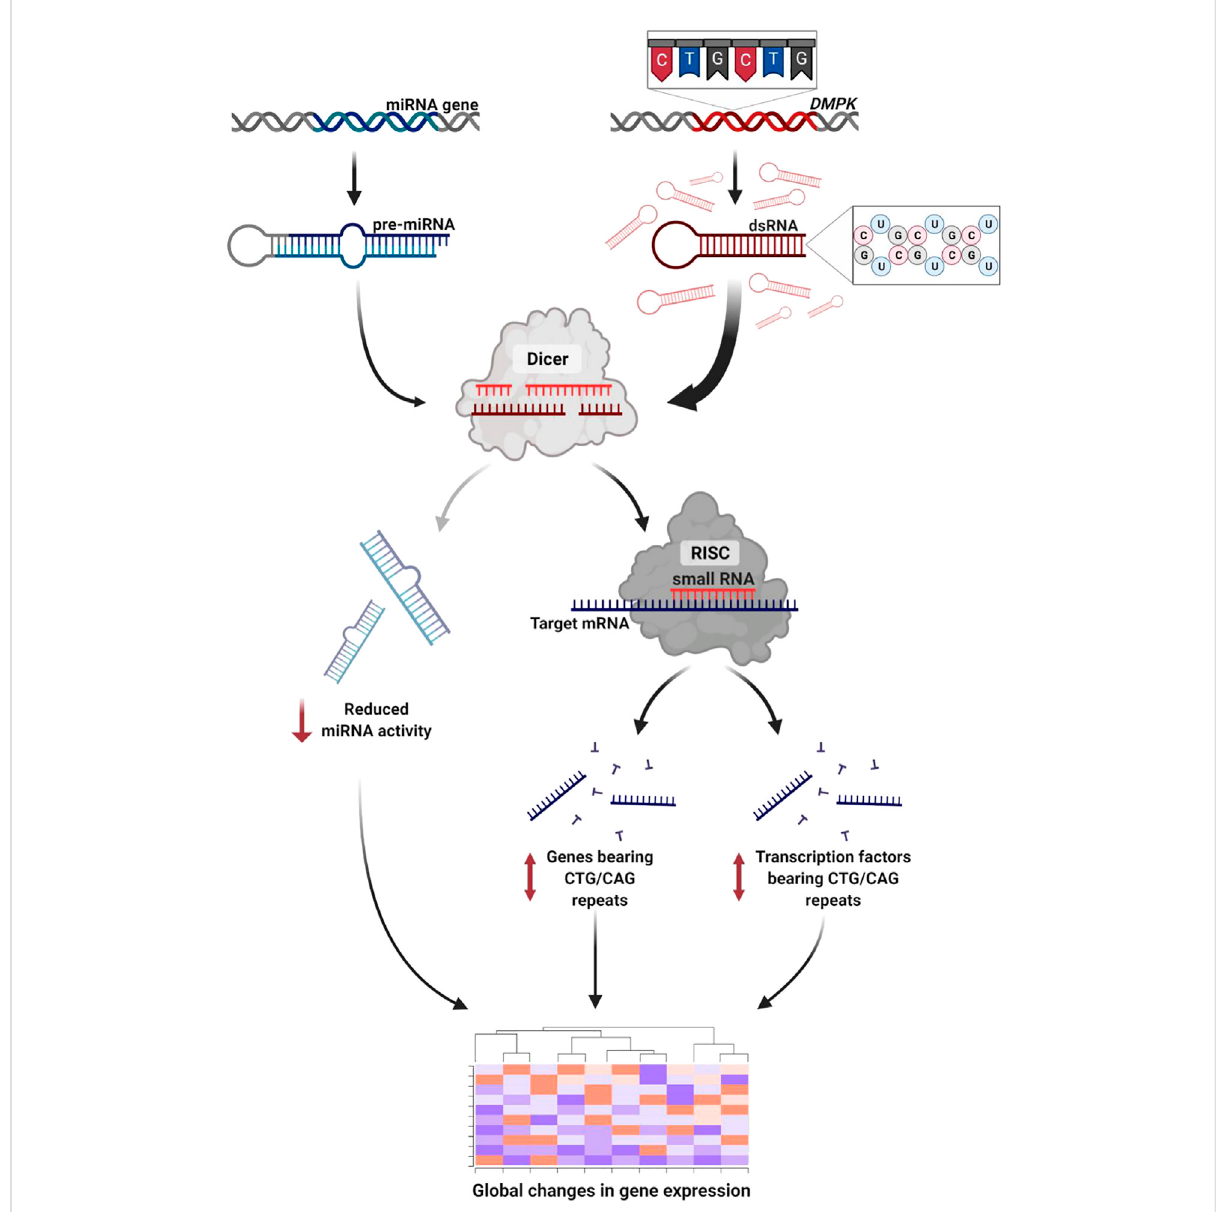
FIGURE 6 RNA interference mediates toxicity in DM1. The expanded repeat sequence is transcribed to toxic RNA that forms stem-loop structures. The double-stranded RNA is subsequently cleaved by Dicer to short-interfering RNA. These activate the RNAi silencing pathway triggering global changes in gene expression through three pathways: 1) Disrupted miRNA activity due to reduced number of miRNAs reaching maturity. 2) Altered expression of genes bearing CTG/CAG repeats. 3) Altered expression of transcription factors bearing CTG/CAG repeats. Created with